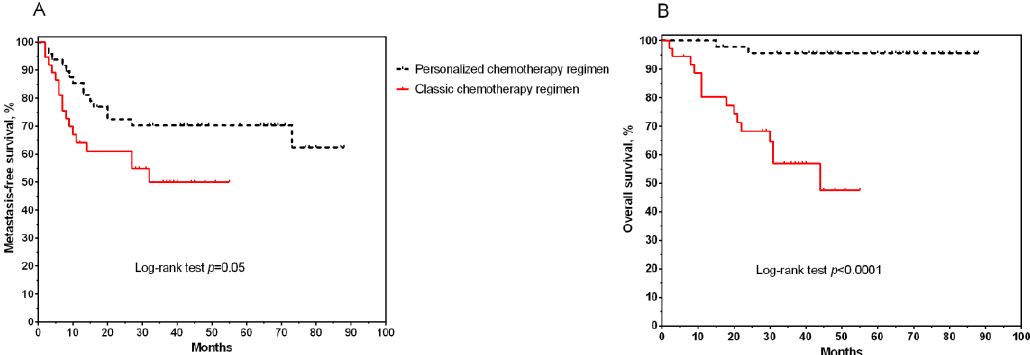
Figure 2. Curves of metastasis-free ( A ) and overall ( B ) survival of patients with non-small-cell lung cancer, depending on the choice of adjuvant chemotherapy regimen.